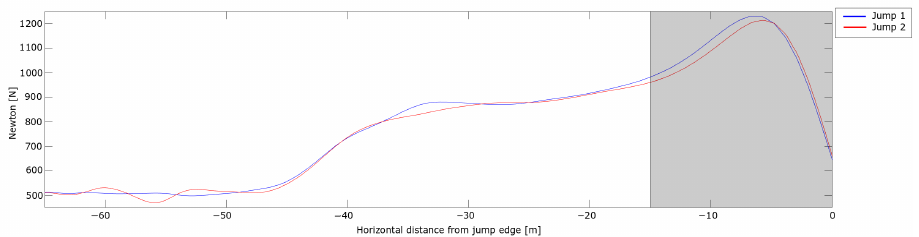
Figure 7. Perpendicular force action on the ski jumper during the in-run. The horizontal length from the in-run edge is shown on the x-axis and velocity is shown on the